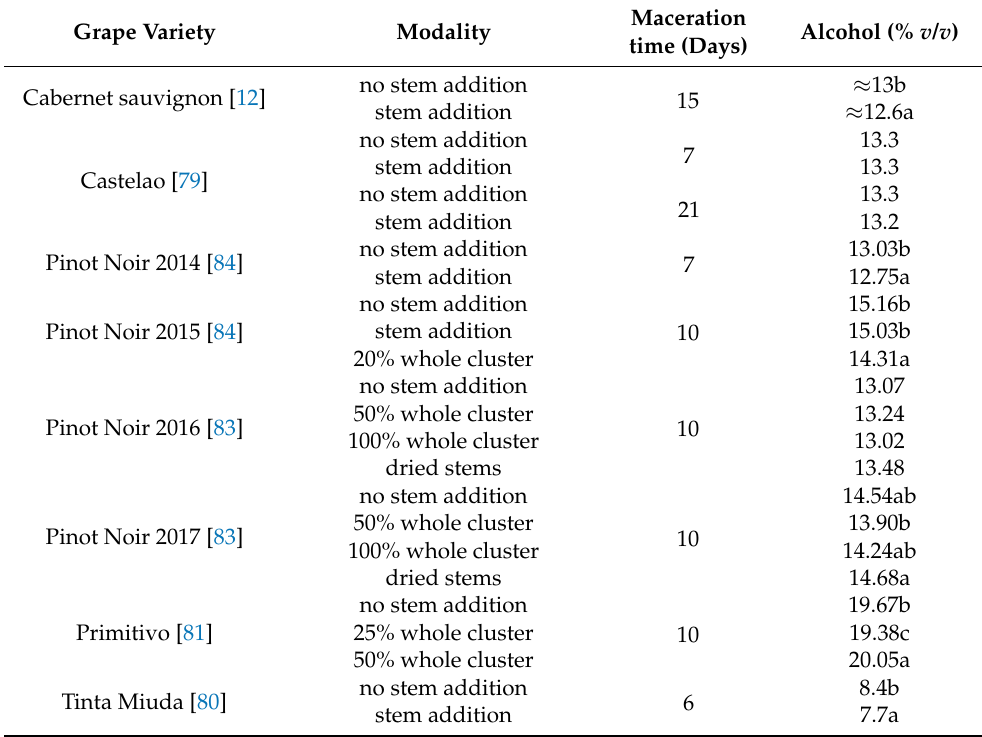
Table 14. Ethanol content in wine made with and without stem addition (for each study, different letters indicate significant statistical